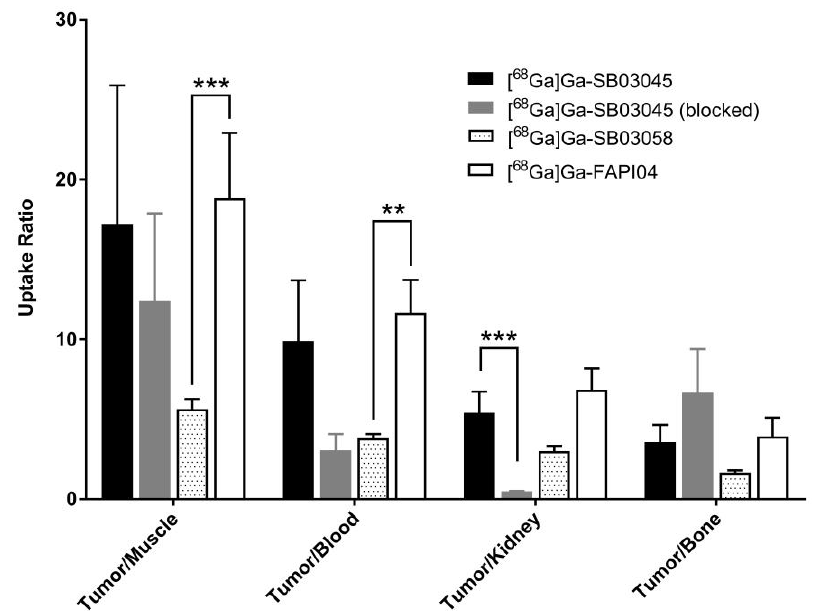
Figure 5. Tumor/organ uptake ratios of [ 68 Ga]Ga-SB03045, [ 68 Ga]Ga-SB03058, and [ 68 Ga]Ga-FAPI-04 in HEK293T:hFAP tumor-bearing male NRG mice at 1 h pi. The mice in the blocked group were co-injected with nat Ga-FAPI-4 (0.5 mg/mouse). ** p < 0.01, *** p < 0.001. Co-injection of [ 68 Ga]Ga-SB03045 with nat Ga-FAPI-04 (0.5 mg/mouse) reduced the av- erage tumor uptake by ~96% (from 11.8 %ID/g to 0.51 %ID/g). In addition, co-injection of [ 68 Ga]Ga-SB03045 with nat Ga-FAPI-04 reduced the average uptake of [ 68 Ga]Ga-SB03045 in normal organs/tissues, including bones (3.48 ± 1.02 %ID/g to 0.09 ± 0.05 %ID/g, Table S1). 2.4. Hydrophilicty/LogD 7.4 Measurement The LogD 7.4 values of [ 68 Ga]Ga-FAPI-04, [ 68 Ga]Ga-SB03045 and [ 68 Ga]Ga-SB03058 were calculated to be −1.9 2 ± 0 .35, −2.8 1 ± 0 .05, and −2.4 9 ± 0.28 respectively (n = 3). LogD 7.4 measurements confirmed the hydrophilic properties of both [ 68 Ga]Ga-SB03045 and [ 68 Ga]Ga-SB03058, and both of them were found to be more hydrophilic than [ 68 Ga]Ga- FAPI-04. 3. Discussion In the present study, we synthesized two novel derivatives of the clinically validated tracer [ 68 Ga]Ga-FAPI-04 and evaluated them for their in vitro and in vivo FAP-targeting capabilities. Substituting the (2 S )-4,4-difluoro-2-pyrrolidinecarbonitrile moiety in [ 68 Ga]Ga-FAPI-04 with (2 S ,4 S )-4-fluoropyrrolidine-2-carbonitrile yielded [ 68 Ga]Ga- SB03045, whereas supplanting it with a (4 R )-thiazolidine-4-carbonitrile provided [ 68 Ga]Ga-SB03058. The (6-(3-(piperazin-1-yl)propoxy)quinoline-4-carbonyl)glycyl frag- ment, previously optimized by Haberkorn et al. [24,26] and found in FAPI-04, was re- tained in both SB03045 and SB03058. Finally, the addition of chelator DOTA allowed the formation of stable complexes with the PET isotope 68 Ga. Modification was only made either to the C4 substituent in the 2-cyanopyrrolidine ring (as in SB03045) or the C4 posi- tion of 2-cyanopyrrolidine ring (as in SB03058), as rationalized below. Structural modeling has shown that FAP contains a well-defined, hydrophobic S1 binding pocket that prefers a P1 proline with an electrophilic 2-substituent (2-cyano- pyrrolidine or 2-Boro-Pro) that can form a covalent adduct with the catalytic serine nucle- ophile [34]. Furthermore, the S1 pocket only tolerates P2 amino acids (Gly and D-Ala) that are small enough to evade steric clashes between FAP and P3 residue or P3 residue’s car- bonyl group.